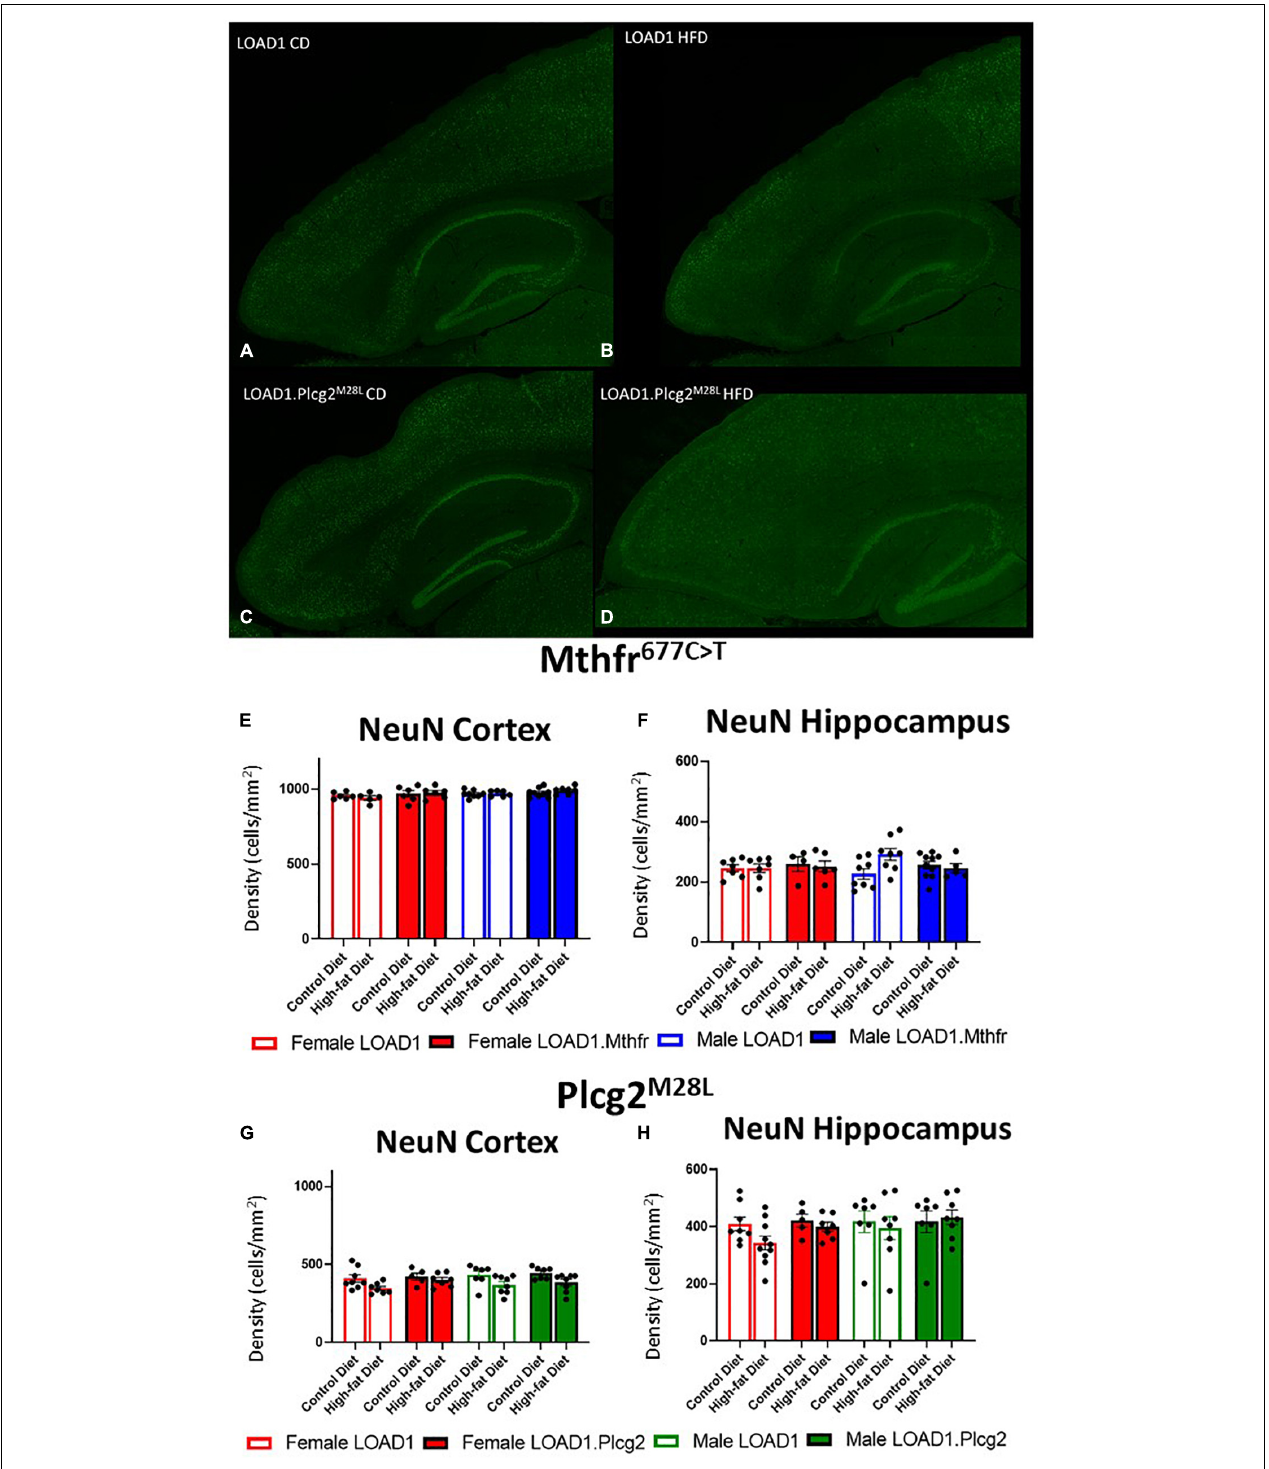
FIGURE 2 | Neuron density is unaffected by HFD in LOAD1. Plcg2 M 28 L and LOAD1. Mthfr 677 C > T mice. Immunohistochemistry was completed using NeuN to visualize the density of neurons (A–D) in the LOAD1. Plcg2 M 28 L mice. The HFD has no significant effect on the density of neurons in either the cortex (E,G) or the hippocampus (F,H) of either LOAD1. Plcg2 M 28 L or LOAD1. Mthfr 677 C > T mice. Statistical analysis was completed using an ANOVA followed by Tukey’s post hoc tests. P < 0.05 is considered significant.